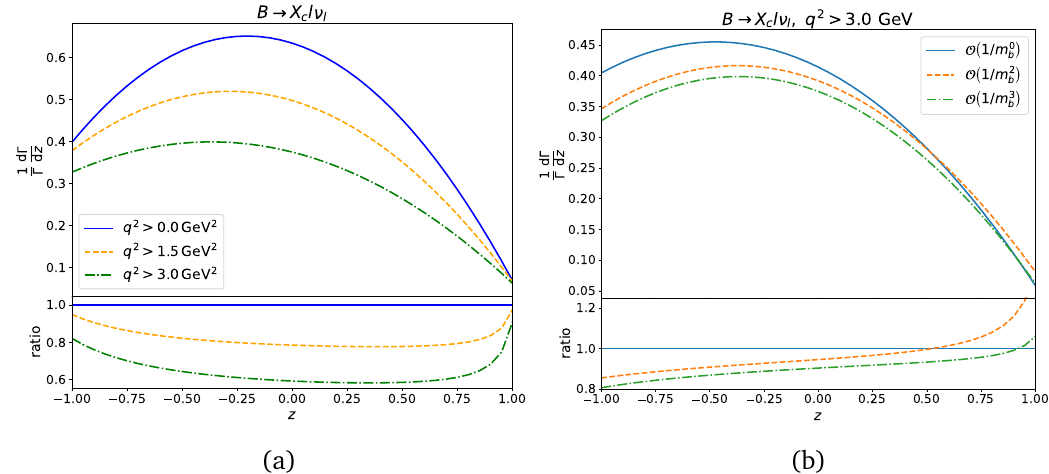
( 1 / m 3 ) for different q 2 cuts. l ν at c l b O l ν at different orders in the HQE for c l